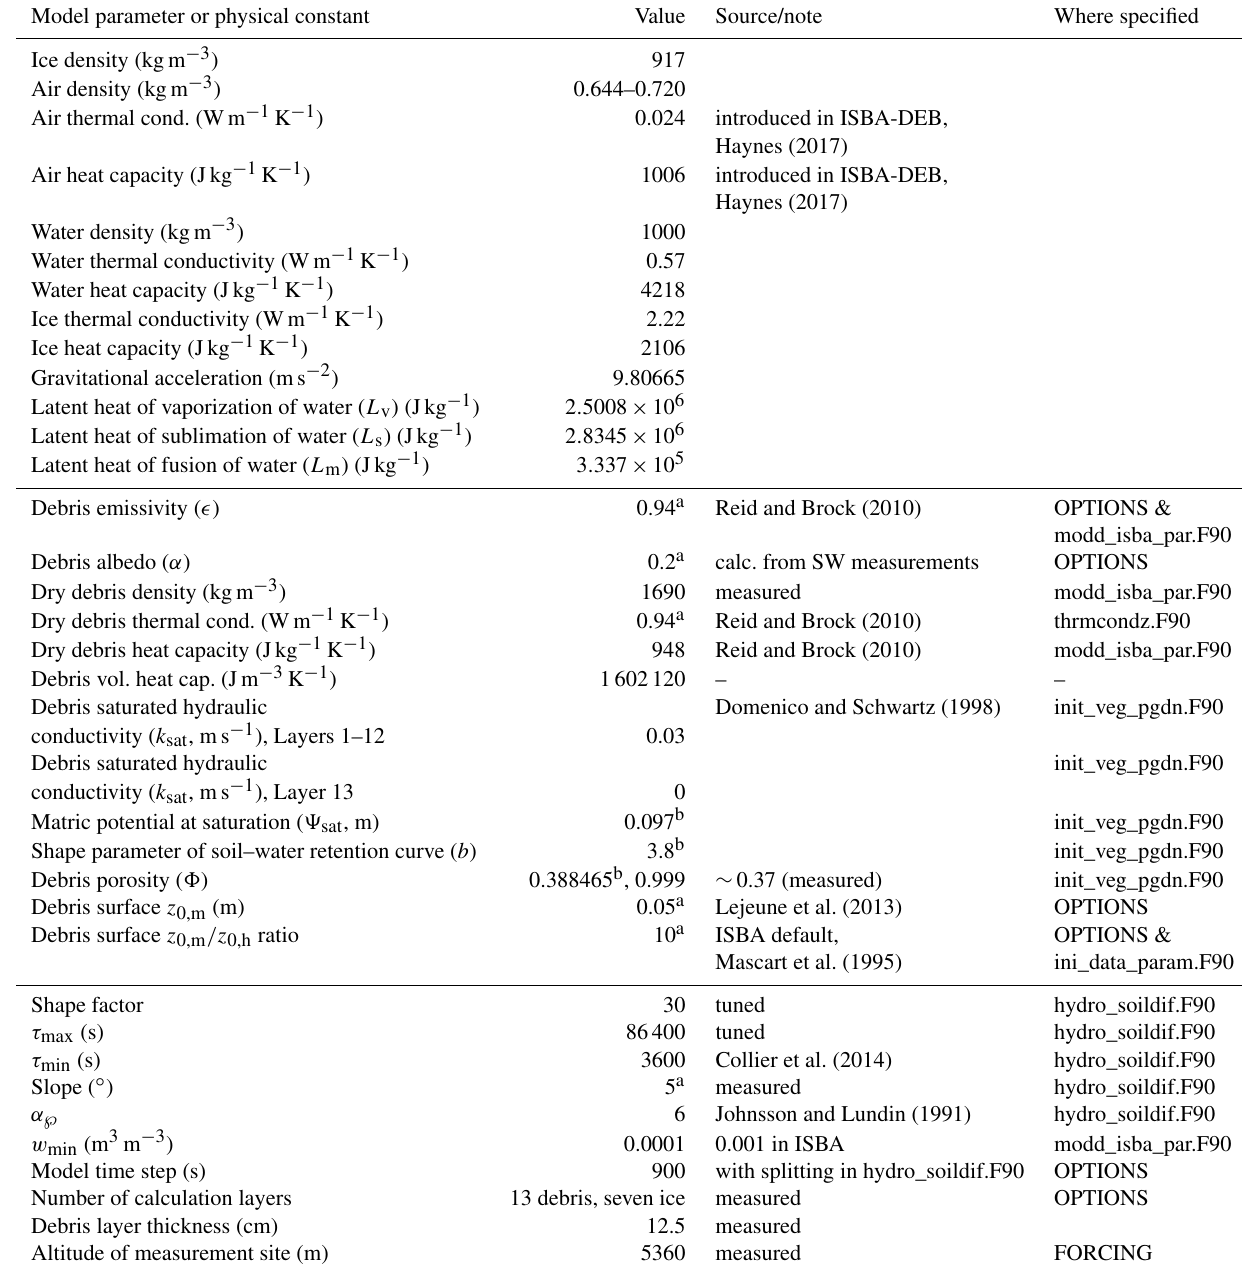
Table A1. Physical constants as well as parameter values used in the baseline ISBA-DEB; sensitivity tests were performed on parameters with a superscript “a”. Superscript “b” appears with values predicted by pedotransfer functions (PTFs) of Noilhan and Lacarrere (1995) (using Clapp and Hornberger, 1978) based upon an input of 98% sand and 2% clay. The calculated porosity given by the PTFs is 0.39, close enough to the measured porosity of 0.37 that we did not overwrite the PTF calculation. The designation of zero hydraulic conductivity of the bottom debris layer simulates an impenetrable glacier surface and ensures no nonphysical drainage out of the debris into the glacier. The third column of the table indicates the file in which these parameters are set, for the future user. Air density is a function, as described in the caption of Table S1. Values for which no references are listed are the standard values used by SURFEX (LeMoigne,